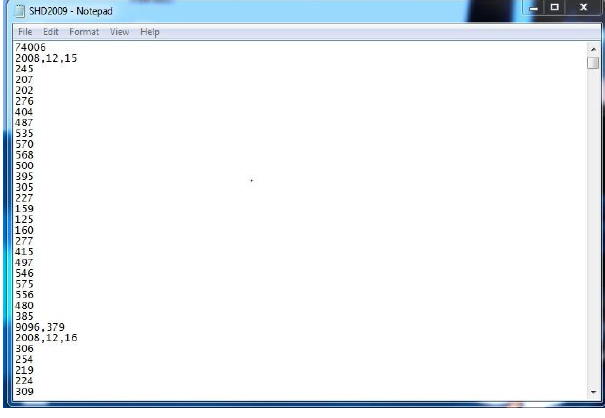
Figure 3. Raw Data from